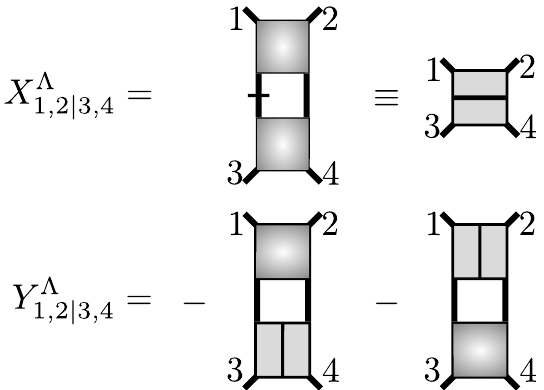
Figure 11: One-loop and two-loop bubble functions from Eqs. (2d) and